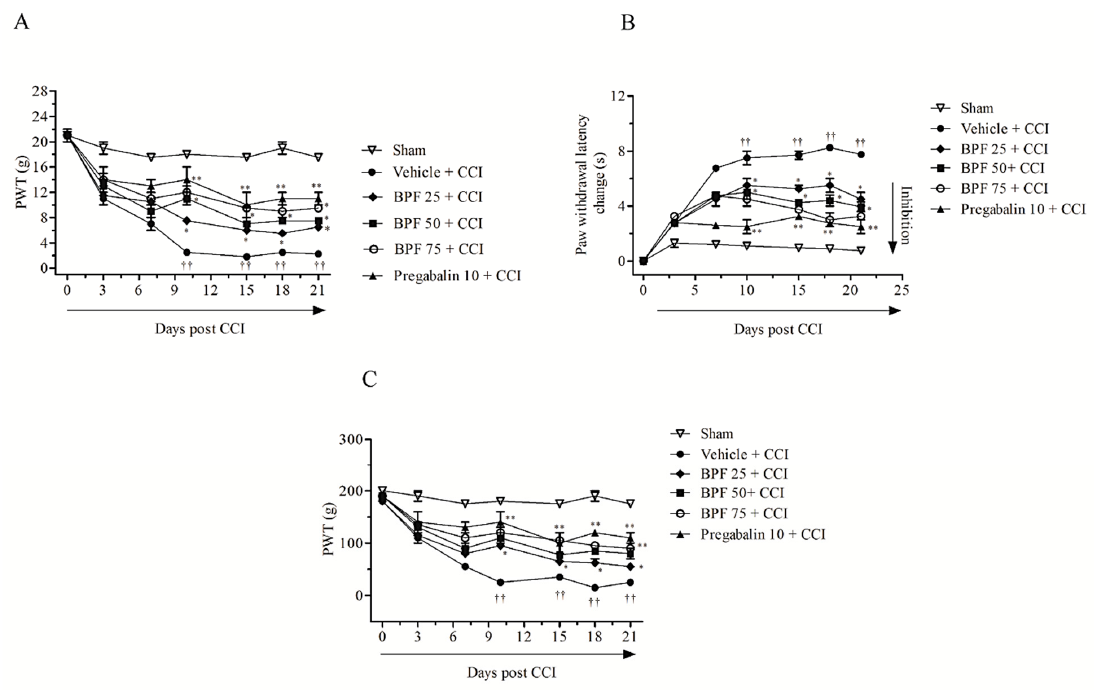
Figure 1. Effects of treatment with bergamot polyphenolic fraction (BPF) on allodynia and hyperalgesia after inducing Chronic Constriction Injury (CCI) in rats. In rats with CCI, subcutaneous infusion of BPF (25–75mg/kg) or pregabalin (10 mg/kg), concurrently with surgery (day 0), attenuated the development of mechano-allodynia ( A ), thermal hyperalgesia ( B ) and mechano-hyperalgesia ( C ) assessed over a 21 days period. Data are expressed as mean ± SEM for 15 rats in each group. * p < 0.05; ** p < 0.005 versus vehicle + CCI, †† p < 0.05 versus sham.